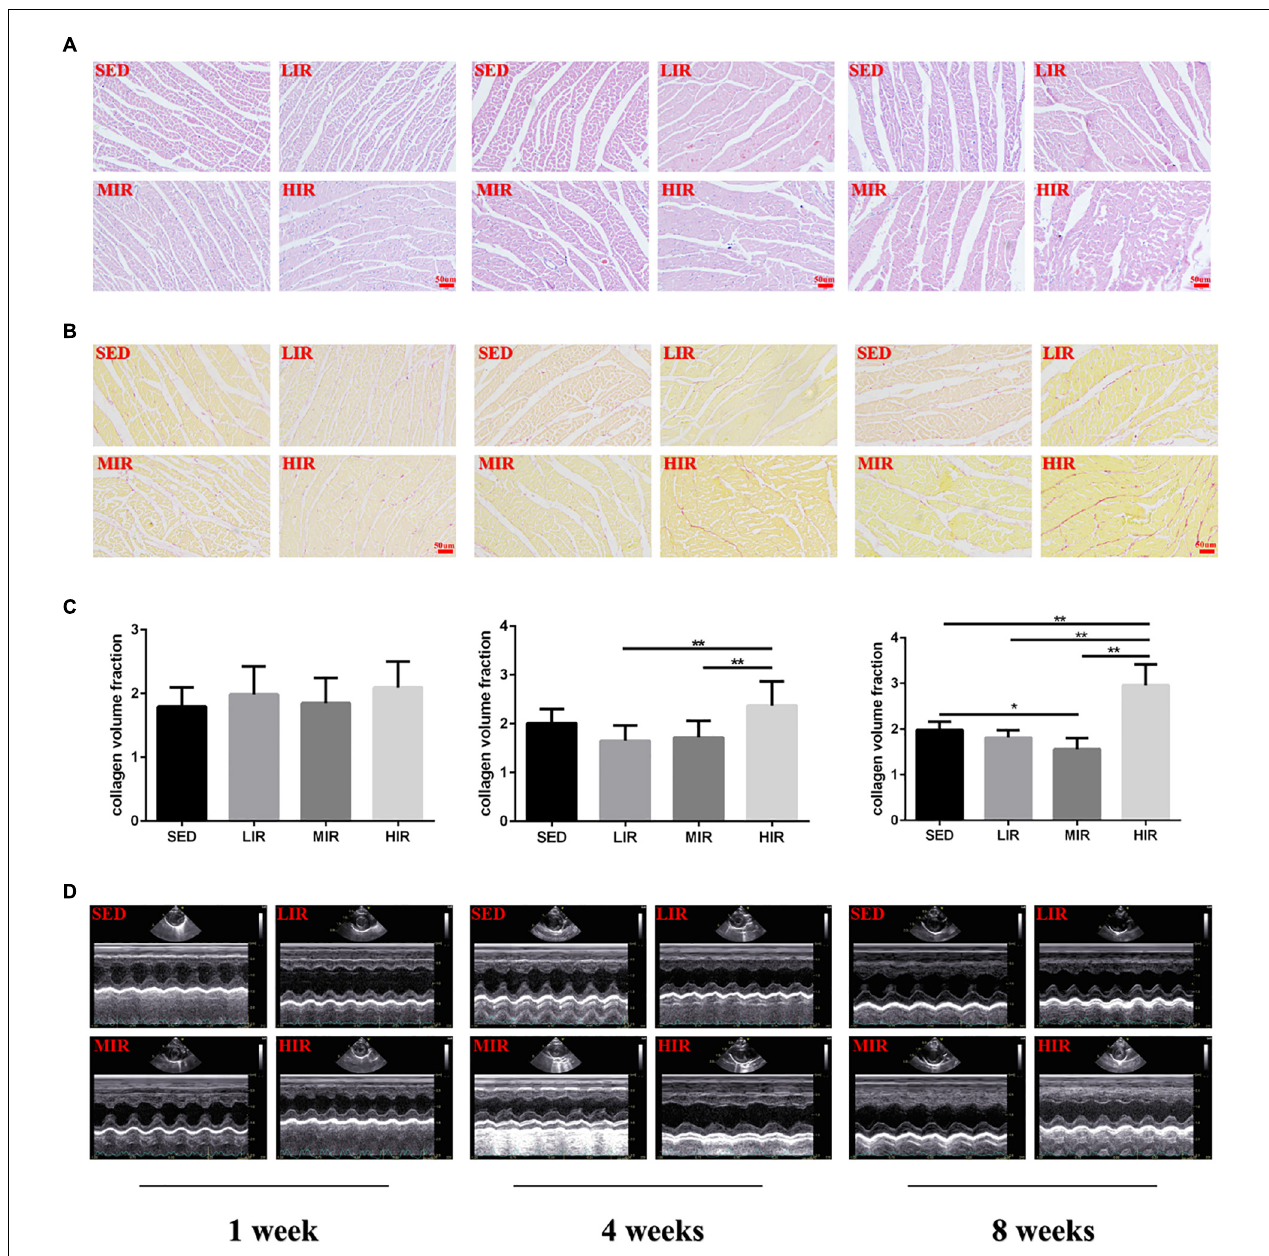
FIGURE 2 | SD rats were subjected to different treadmill running intensities for 1, 4, and 8 weeks. (A–C) Histological changes of the hearts were observed by HE staining (A) , PSR staining (B,C) . Scale bar: 50 µ m (A,B) . (D) Typical M-mode images of echocardiogram in the left ventricle. Data are presented as the means ± SEM. * P < 0.05, ** P <